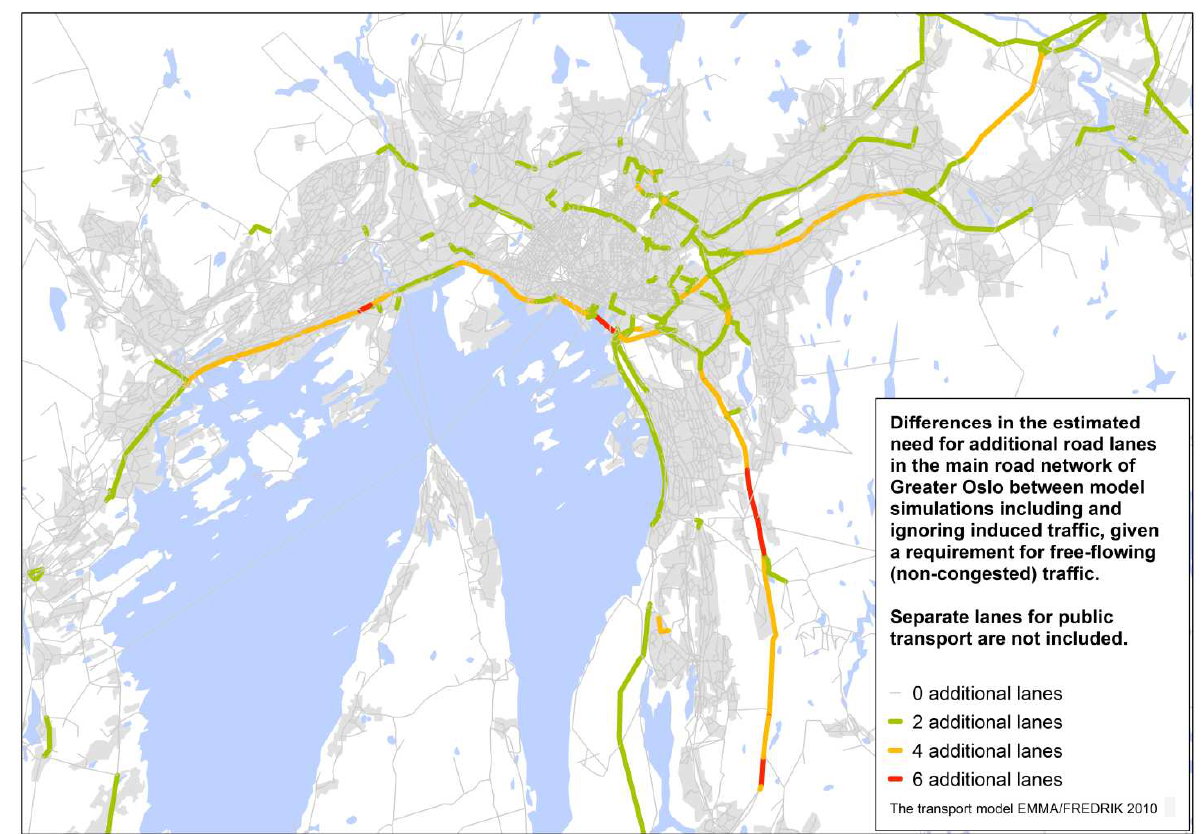
Figure 2. Differences in the estimated need for additional road lanes in the main road network of Greater Oslo between model simulations including and ignoring induced traffic, given a requirement for free- flowing (non-congested) traffic. Source: Simulation made specifically for this article, carried out by Andersen